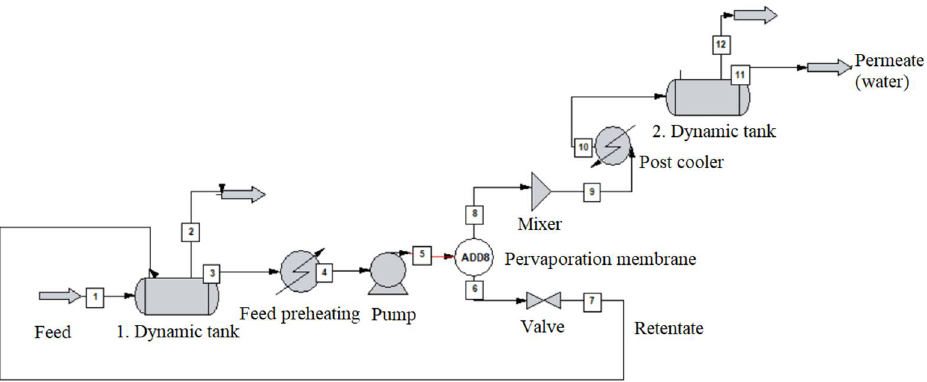
Figure 5. Flowsheet of dynamic organophilic pervaporation method.